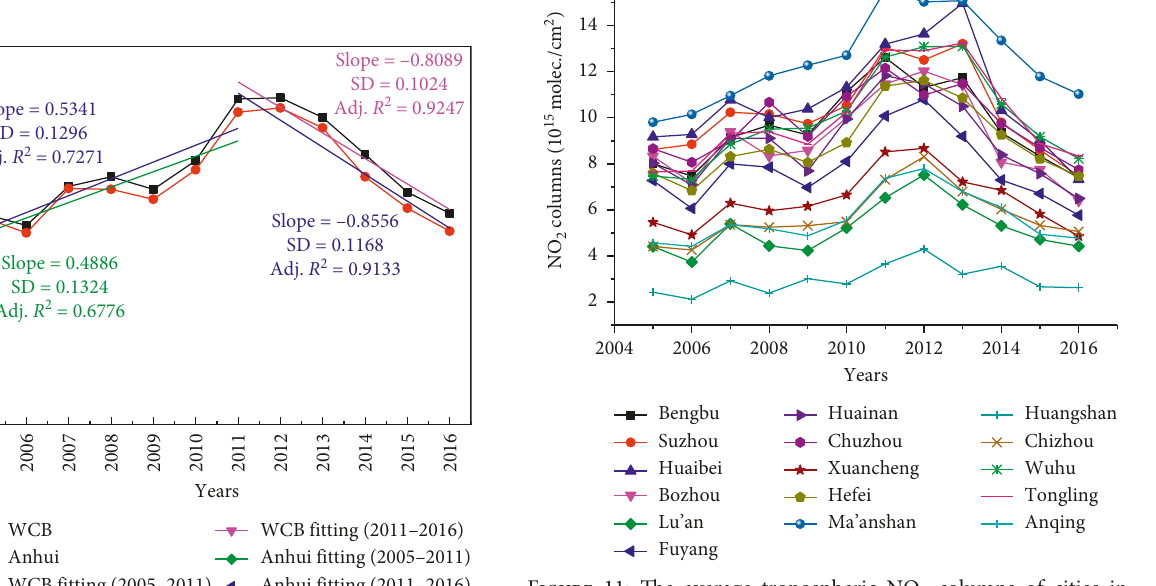
2 columns of cities in